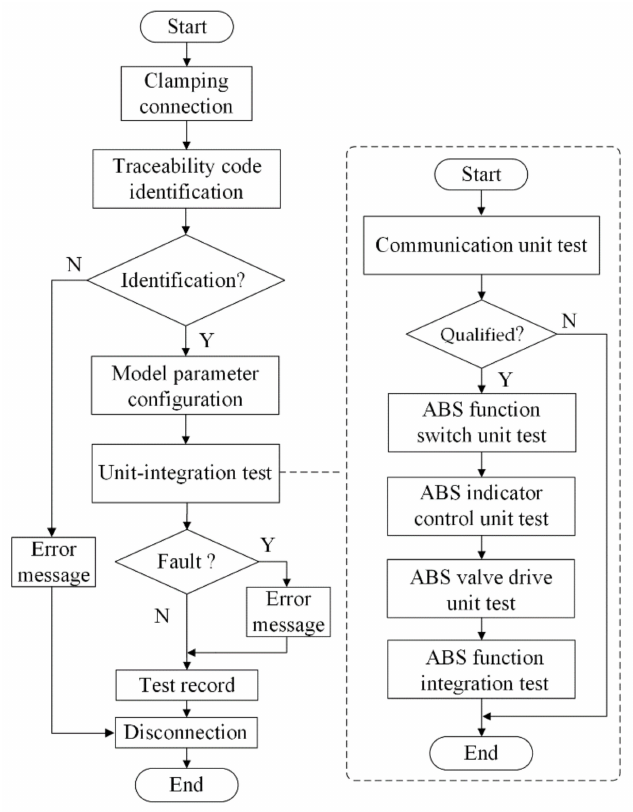
Figure 2. Workflow of the EOL test.